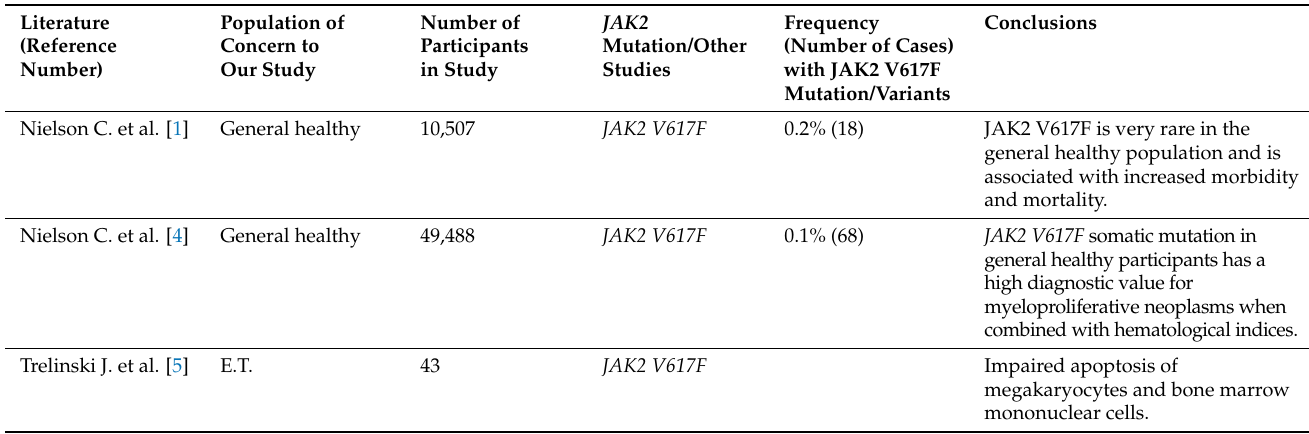
Table 1. JAK2 mutation in the